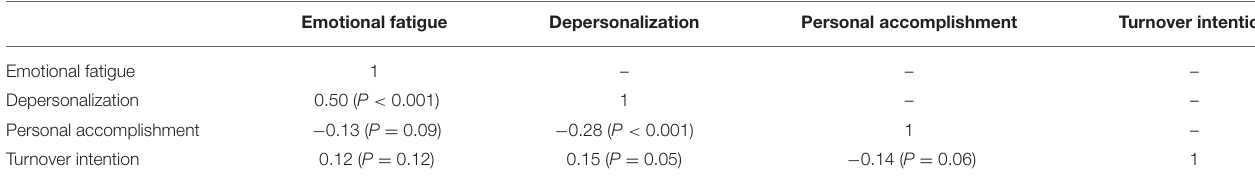
TABLE 2 | Pearson correlation coefficients between different dimensions of burnout with each other and turnover